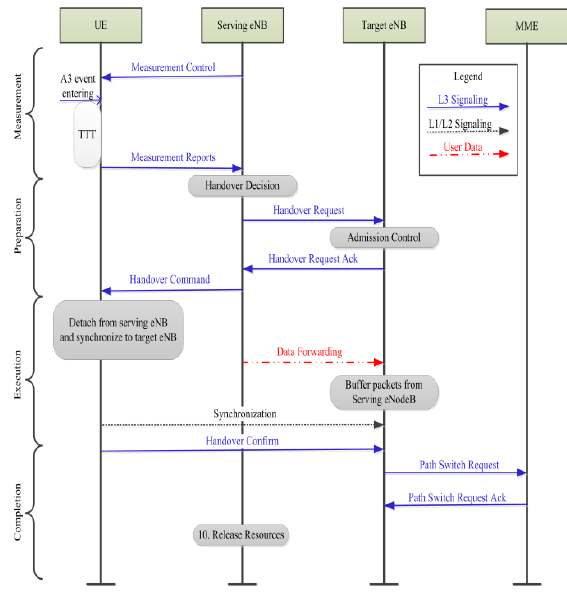
Fig. 2. The handover procedure specified in LTE Release